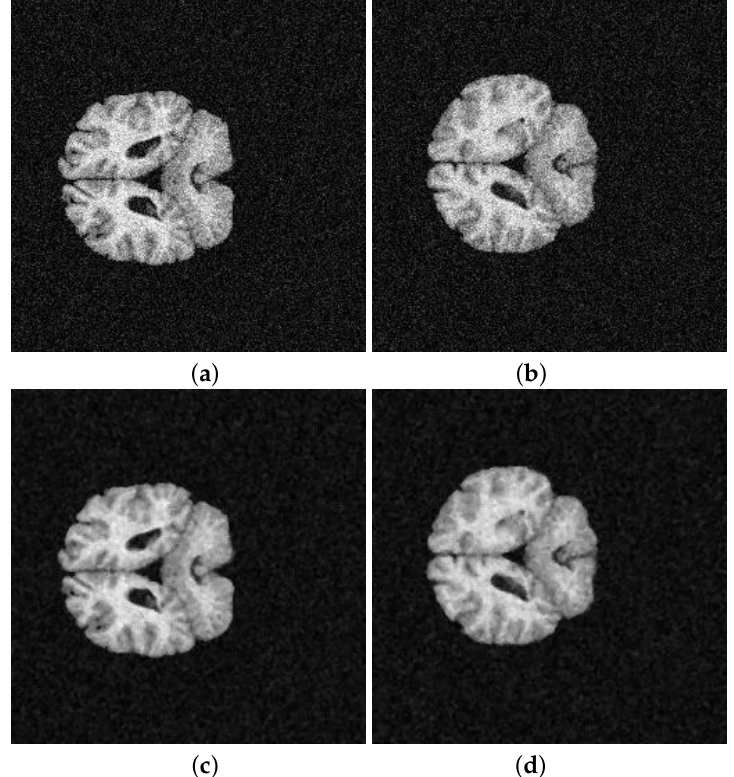
Figure 8. The 202-3 ( a ) and 205-3 ( b ) images with added noise and the pre-processed images using the median filter ( c , d